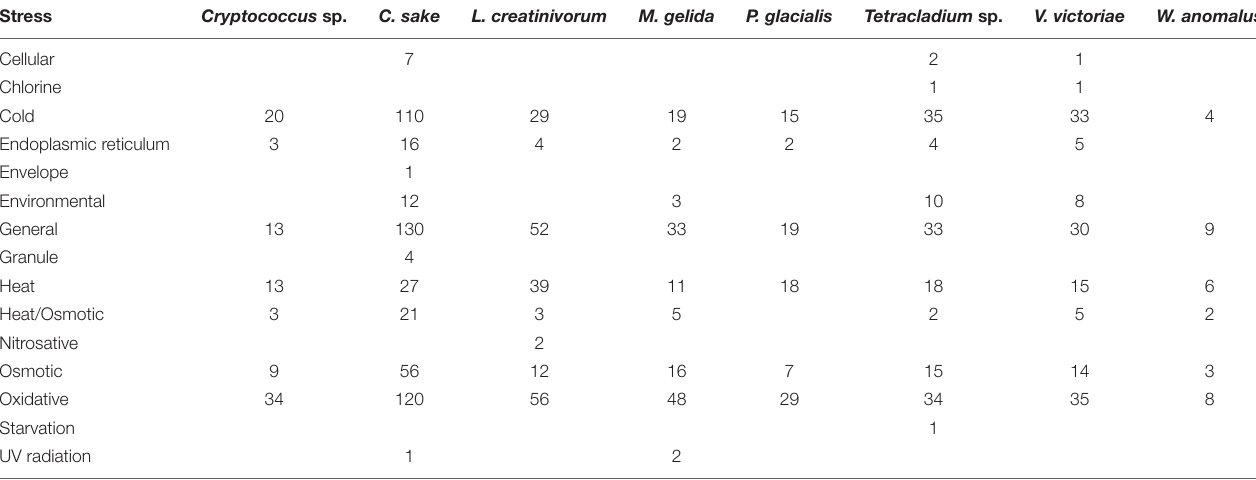
TABLE 3 | Number of CDSs predicted in stress categories for each category in Antarctic yeasts. Stress Cryptococcus